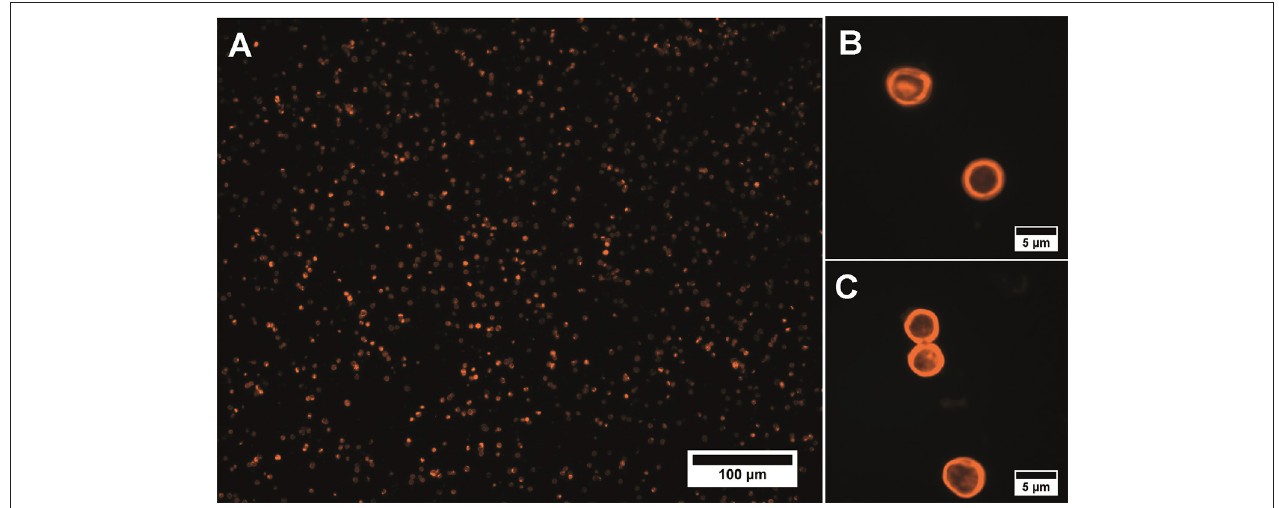
FIGURE 1 | Fluorescent microphotographs of the QD-encoded microparticles at magnifications of (A) 20 × and (B,C) 100 × .